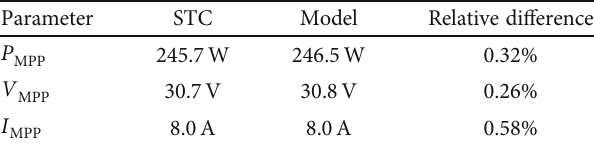
Table 2: SDM validation in STC.